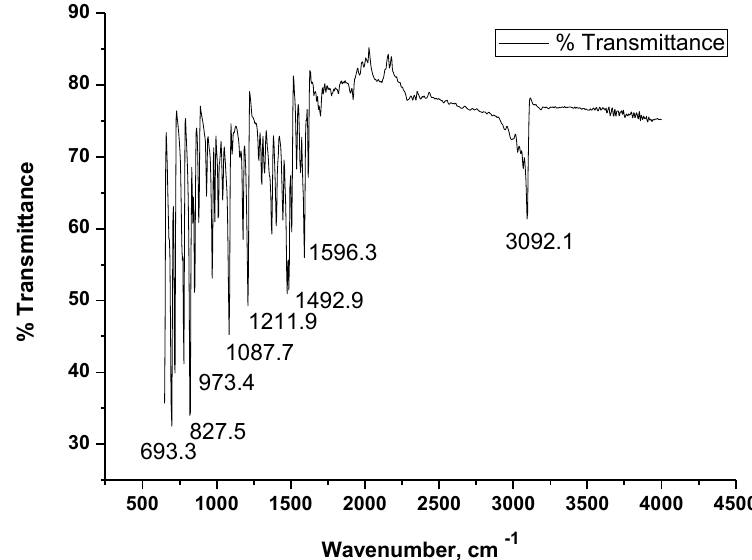
Figure 5. FTIR spectrum of the copper complex ( 6 ).